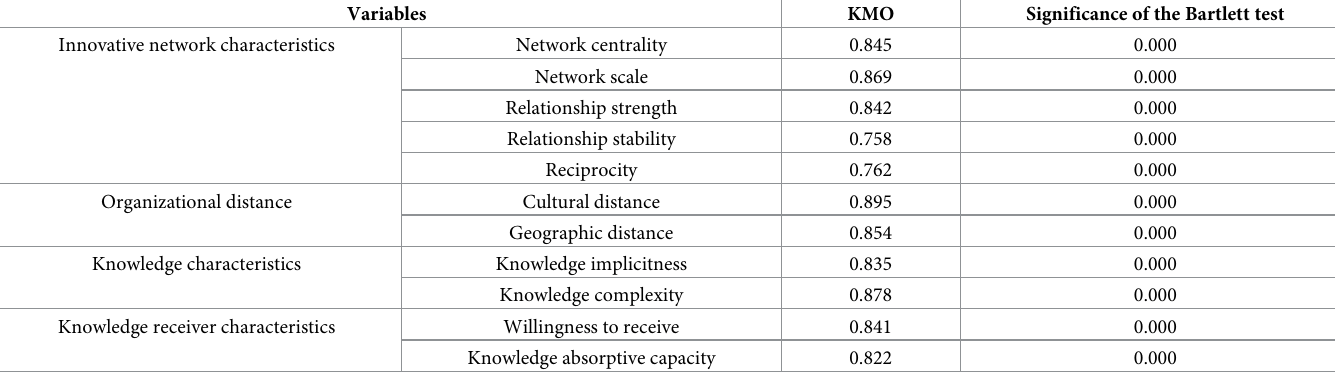
Table 6. Validity test scale